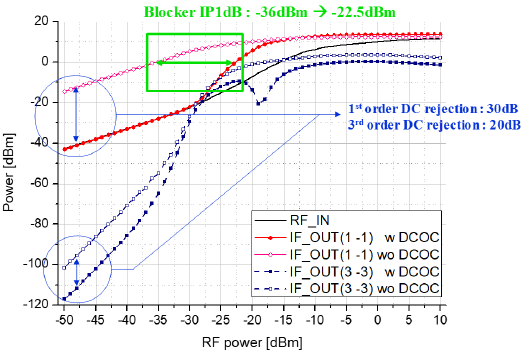
Figure 23. Blocker P1dB and DC rejection simulation result of proposed receiver.